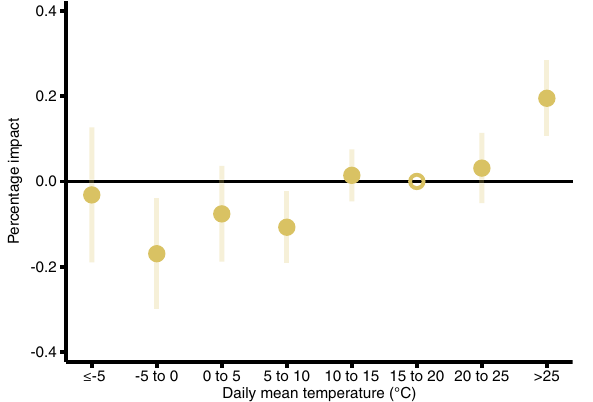
Figure 2. Percentage impact of early pregnancy temperature exposure on the clinically unobserved pregnancy loss rate. The percentage impact of early pregnancy exposure to one additional day with different mean temperatures on the clinically unobserved pregnancy loss rate (relative to a day with a mean temperature of 15–20 °C) assuming that 40% of conceptions are lost before clinical recognition. The early pregnancy period is defined as a six-week-long period starting after the week of conception. The shaded area and the error bars represent 95% confidence intervals. The estimates come from Eq. (9), whereas the percentage impacts are calculated by Eq. (11). See notes to Fig. 1 for details on the estimated